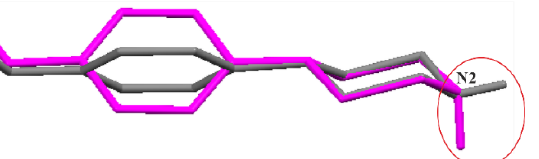
Figure 7. Superimposed molecular structures of N -(4-methoxyphenyl)piperazine (MeOPP): a component from the optimized pair of (II) (magenta) and IHILOD (grey) [21].